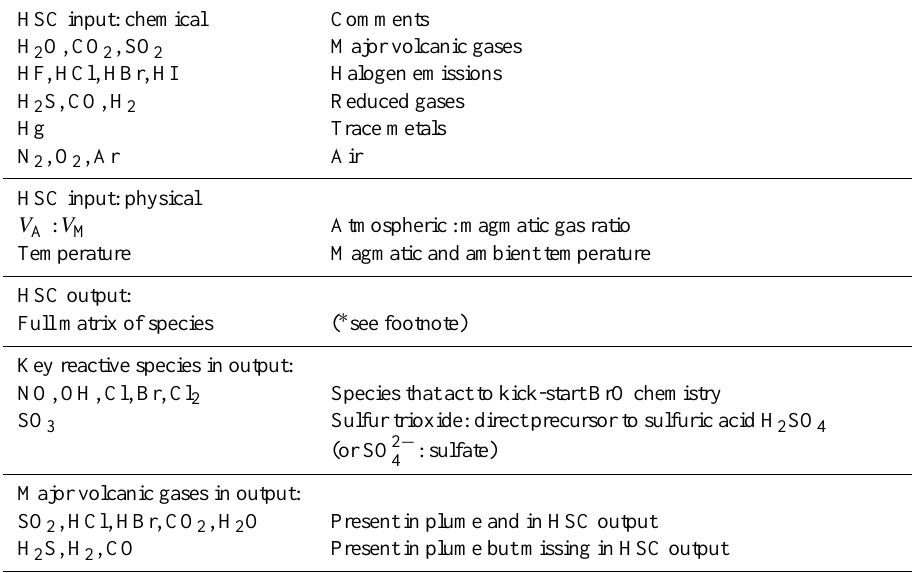
Table 1. Thermodynamic modelling of the high-temperature near-vent plume using HSC: overview of inputs and outputs. HSC input: